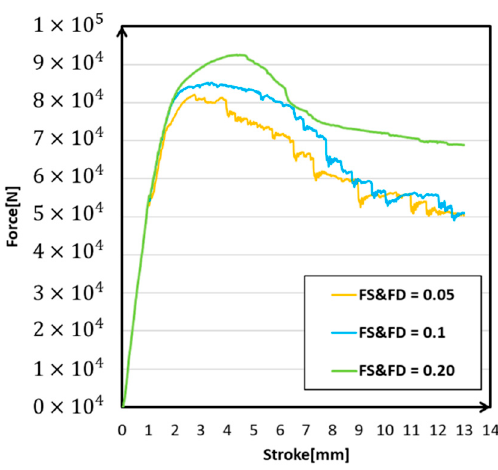
Figure 16. Force-stroke cruves under different friction conditions.